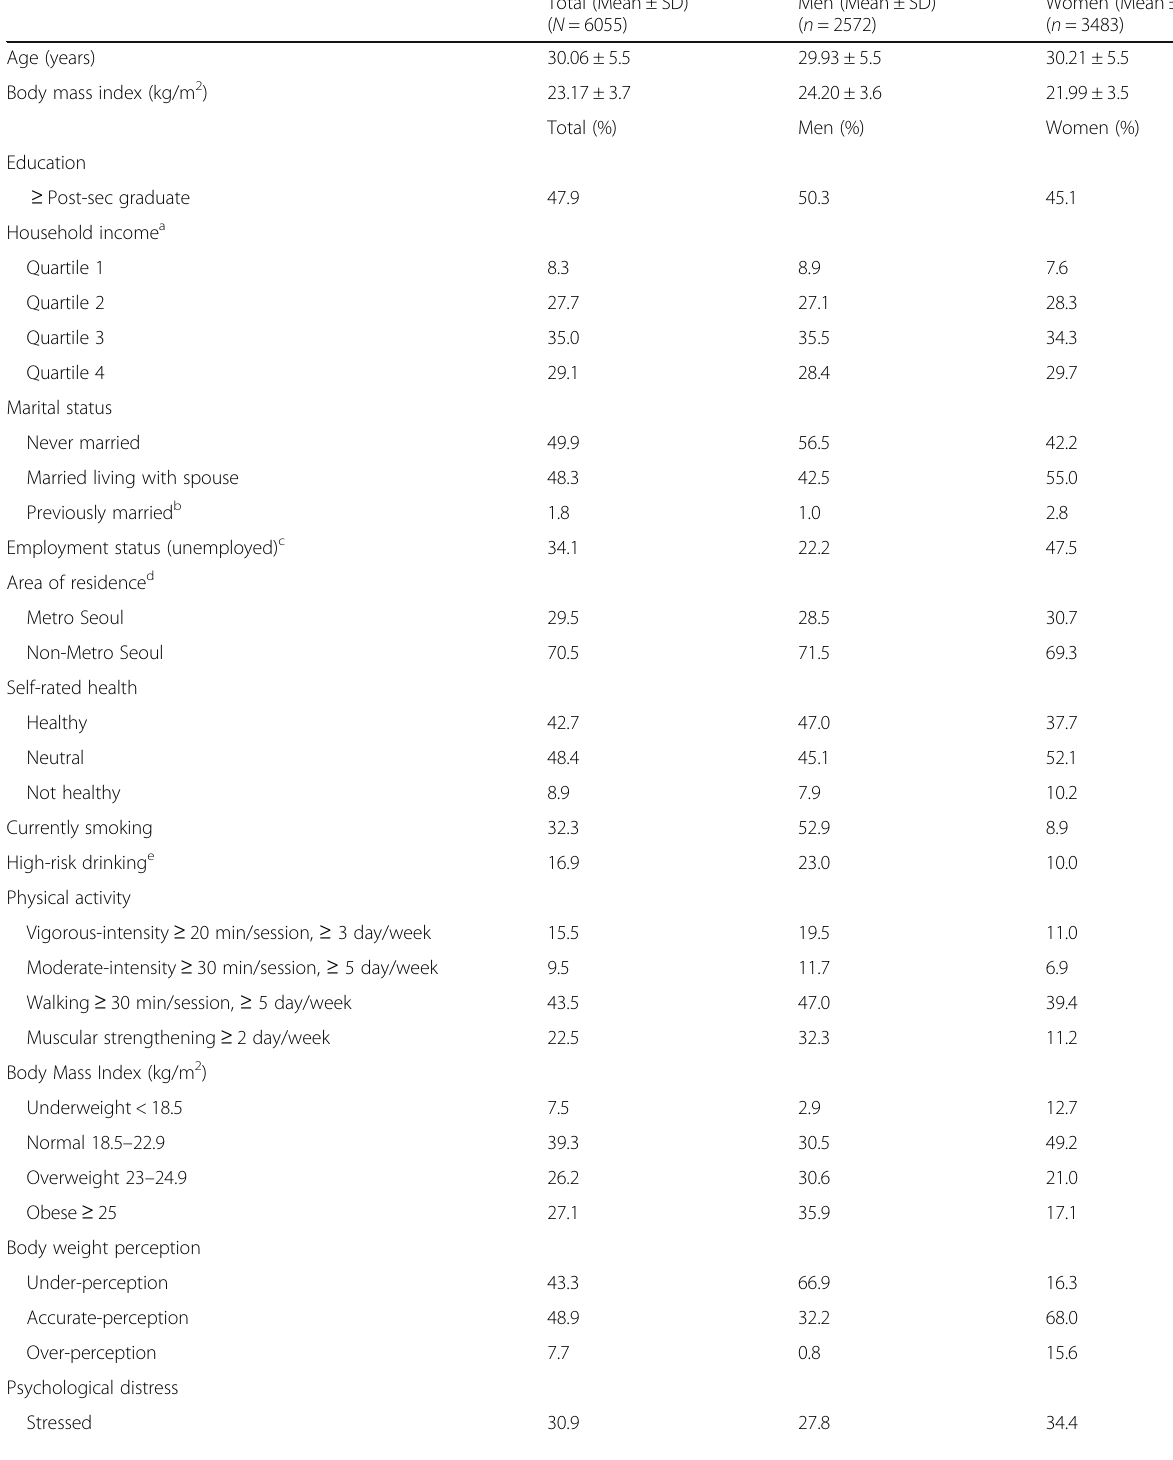
and Nutrition Examination Survey (KNHANES) ( N =